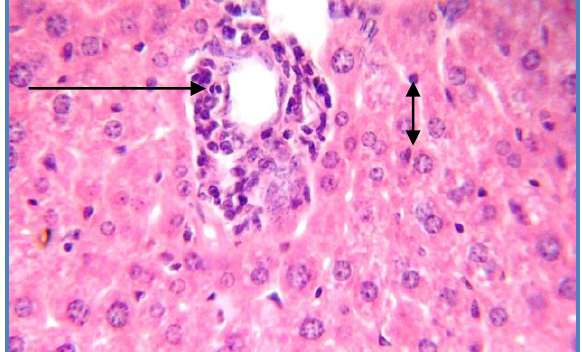
Figure, 10: Liver of mice at 10 days post infection by Candida albicans and treated with Datura stramonium extract after 8 days ( ) shows MNCs aggregation in the portal area with marked proliferation of Kupffer cells ( ) (Heamatoxcyline and Eosin stain 40X).